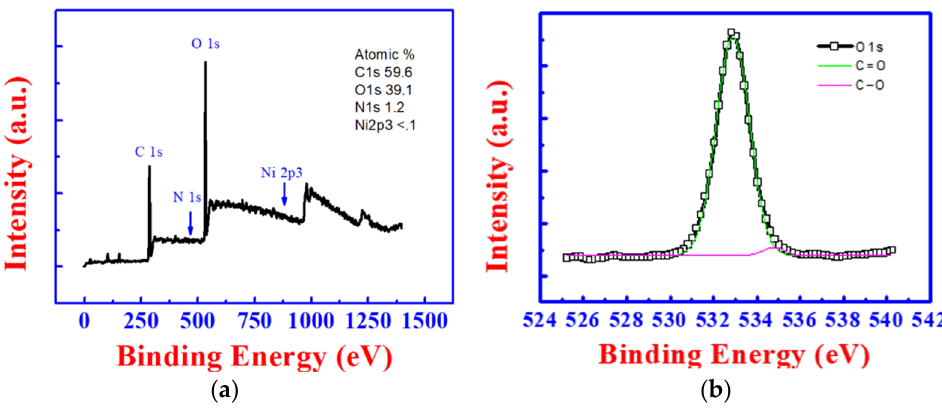
Figure 1. XPS characterization of ( a ) as-fabricated APN film, and ( b ) high-resolution spectra of O1s.